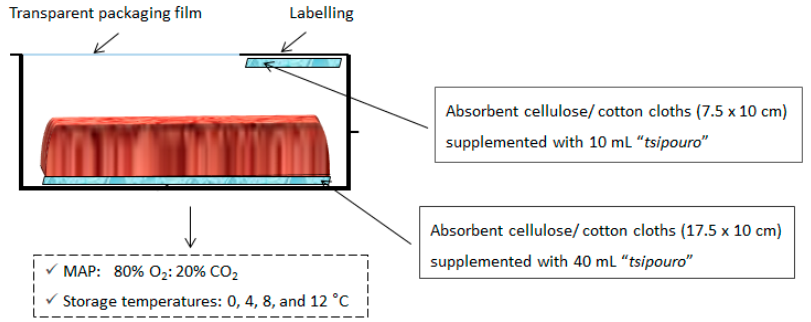
Figure 1. Proposed antimicrobial active packaging of ground beef (500 g) by applying “ tsipouro ” under modified atmosphere packaging (MAP) of 80% O 2 : 20% CO 2 .